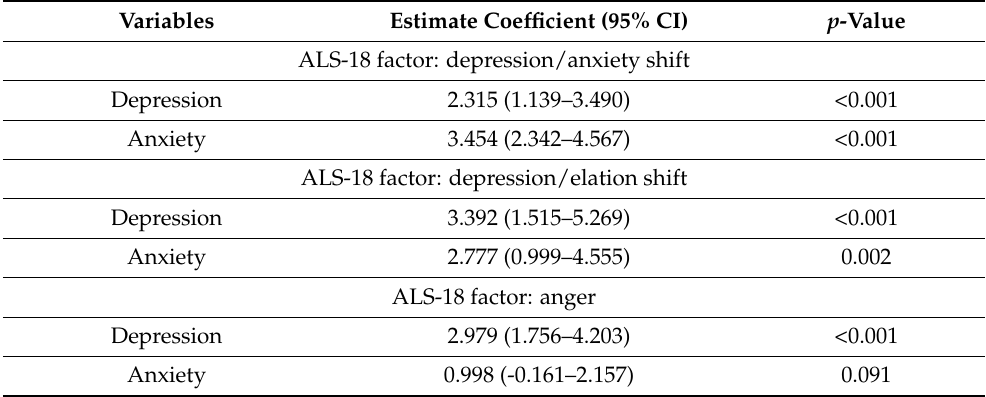
Table 4. Linear regression results of associations between three dimensions of ALS-18 and depression and anxiety ( n =